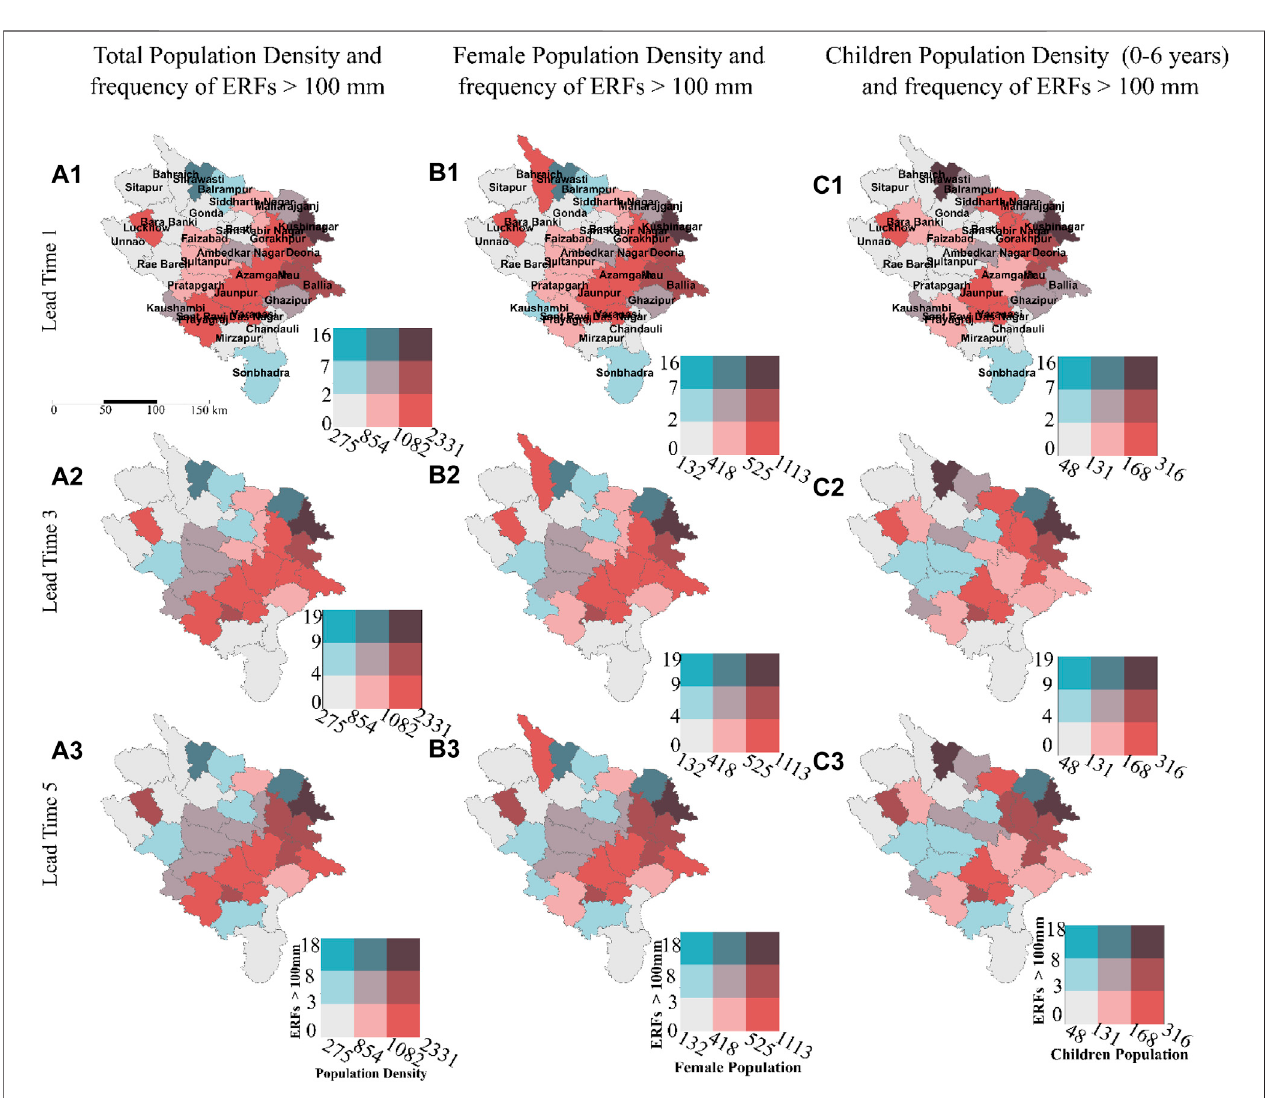
FIGURE 3 | A bivariate choropleth map showing the combined effect of the number of ERFs with the total population density (Panels (A1 – A3) ), female population density (Panels (B1 – B3) ) and children population density (Panels (C1 – C3) ) at three lead times and 100 mm threshold.